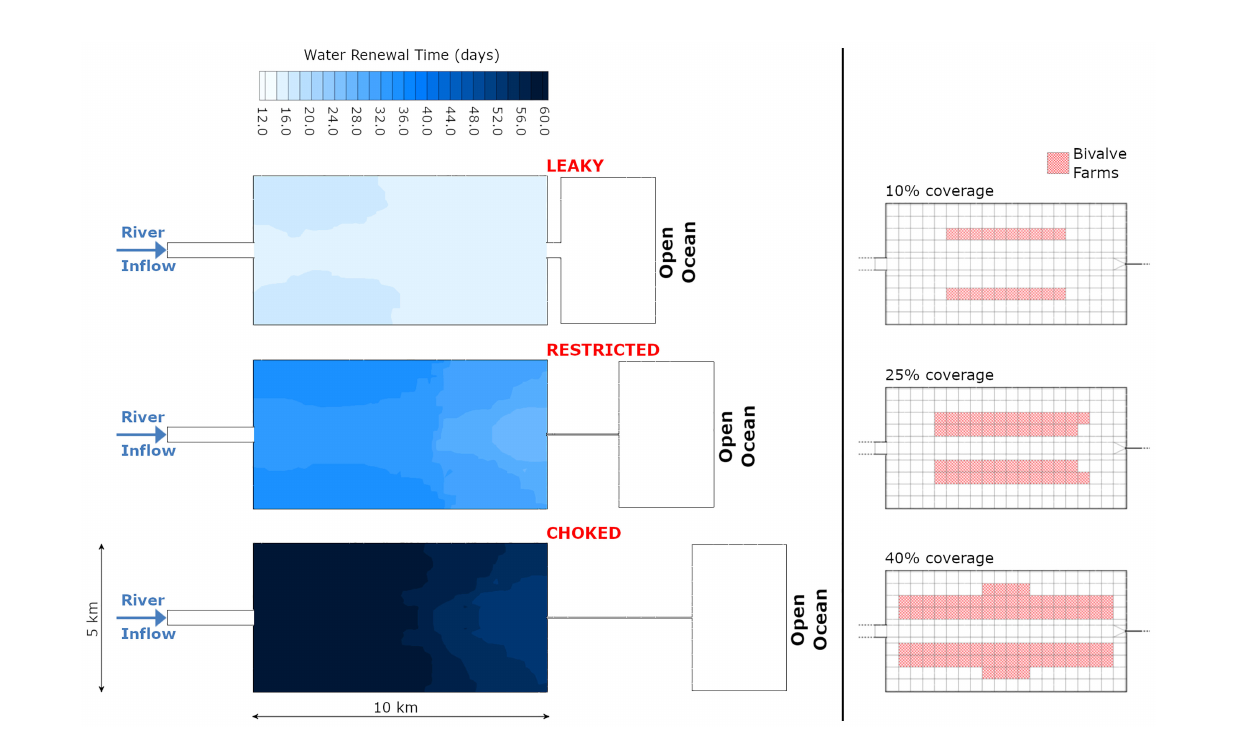
FIGURE 1 | Inlet con fi guration and water renewal time for the three bay geomorphology types (left) and bivalve farm stocking areas for the three aquaculture scenarios